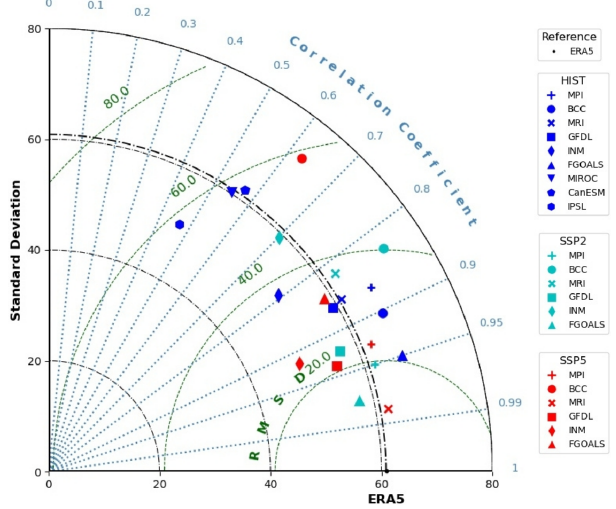
Figure 1. Taylor diagram for the mean composites over all block- ing events for ERA5 and all GCMs for the winter HIST period (1980–2009). The diagram allows us to quantify standard devi- ation (black), correlation coefficient (light blue), and root-mean- square difference (green) between the mean GCM composites and the mean ERA5 composite. SSP2 and SSP5 results are obtained with (cid:49) Z500 SSP2 and (cid:49) Z500 SSP5 ,